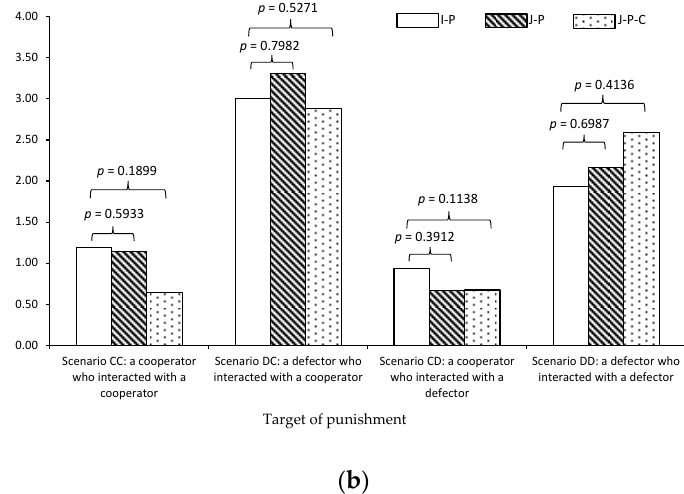
Figure 1. Frequency of Punishment, and Average Strength of Punishment: ( a ) Frequency of Punishment; ( b ) Average per PD player Punishment Points Received. p -values for two-sided Fisher’s exact tests in panel ( a ) and two-sided Mann–Whitney tests in panel ( b ). The punishment frequency and strength are also not significantly different between the J-P and J-P-C treatments for each of the four scenarios ( p > 0.010): p -values are omitted from the panels to conserve space.